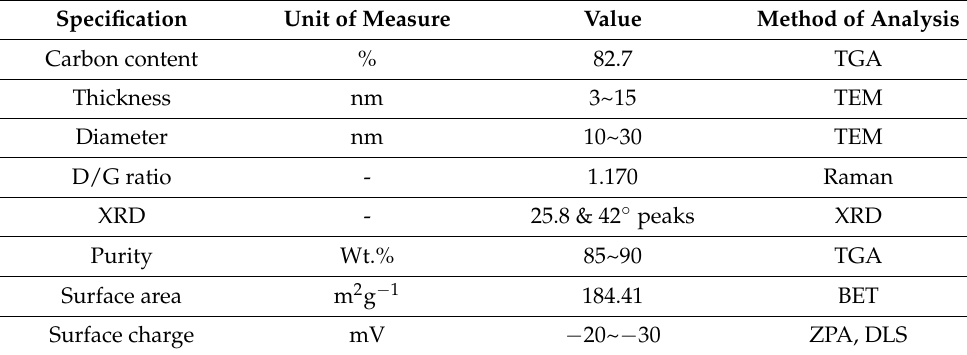
(Table 3). The particle size distributions measured using the dust monitor in the study were 265, 357, and 357 nm for the low, moderate, and high concentrations, respectively. Meanwhile, the MMAD and GSD measured in the STIS were 168 nm (4.24), 280 nm (3.5), and 209 nm (4.3) for the low, moderate, and high concentrations, respectively (Table 3). Table 2. CNF physicochemical information.